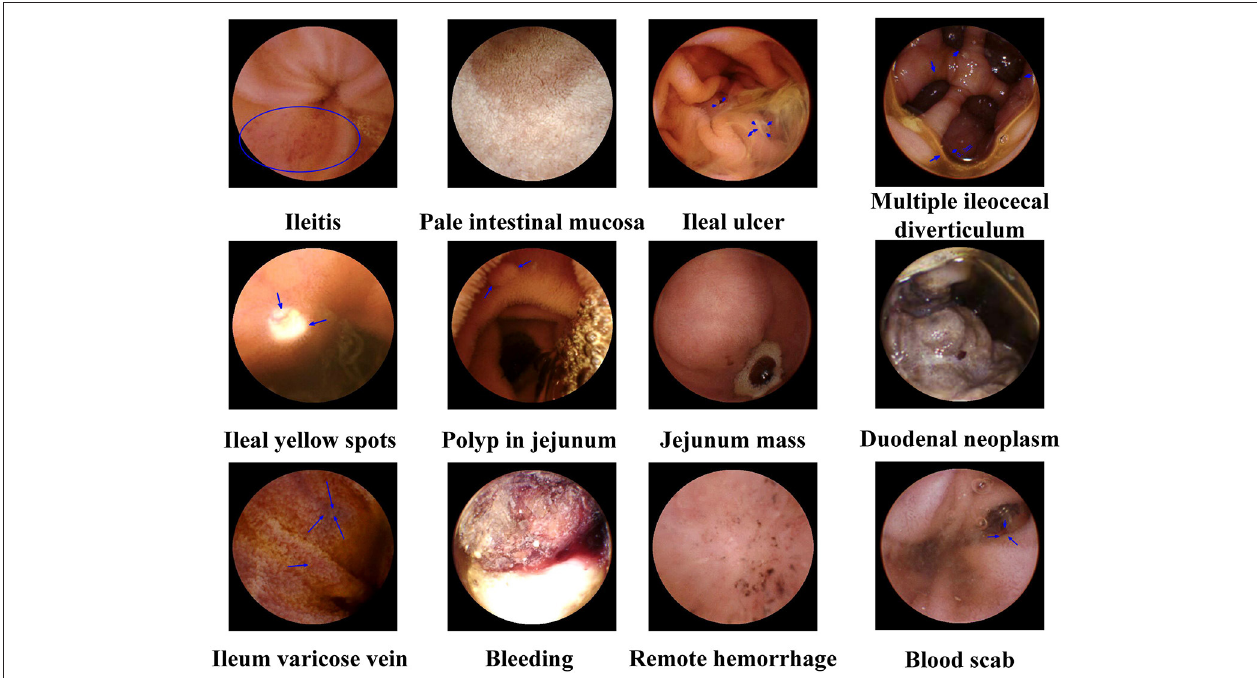
FIGURE 3 | Representative magnetically controlled robotic capsule endoscopy (MCRCE) images of small bowel (duodenum, jejunum, and ileum)